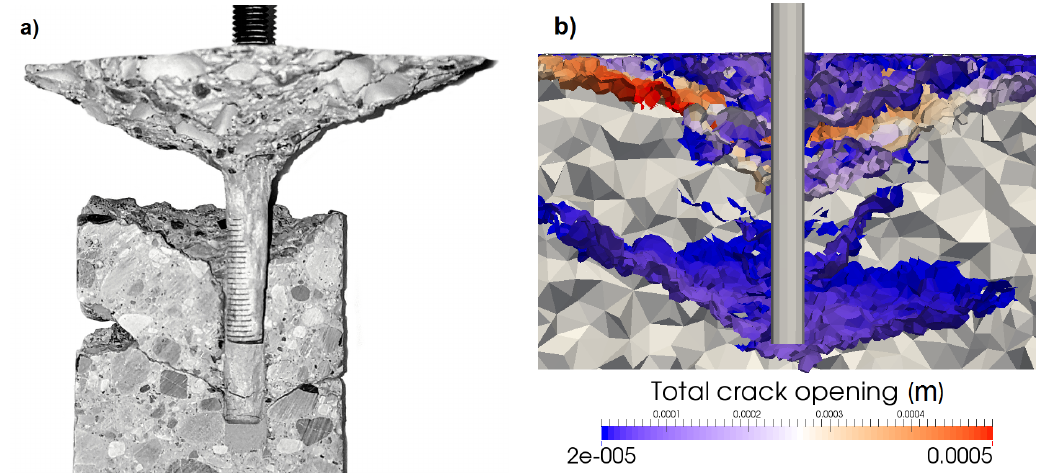
Figure 10. Double cone determined ( a ) experimentally and ( b )